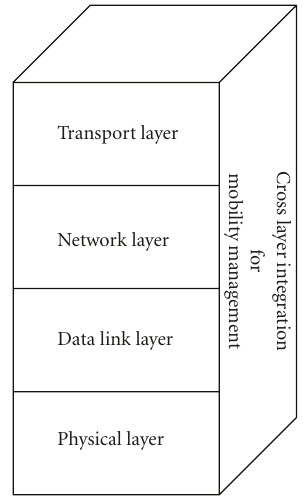
Figure 1: Protocols’ stack integrated with mobility